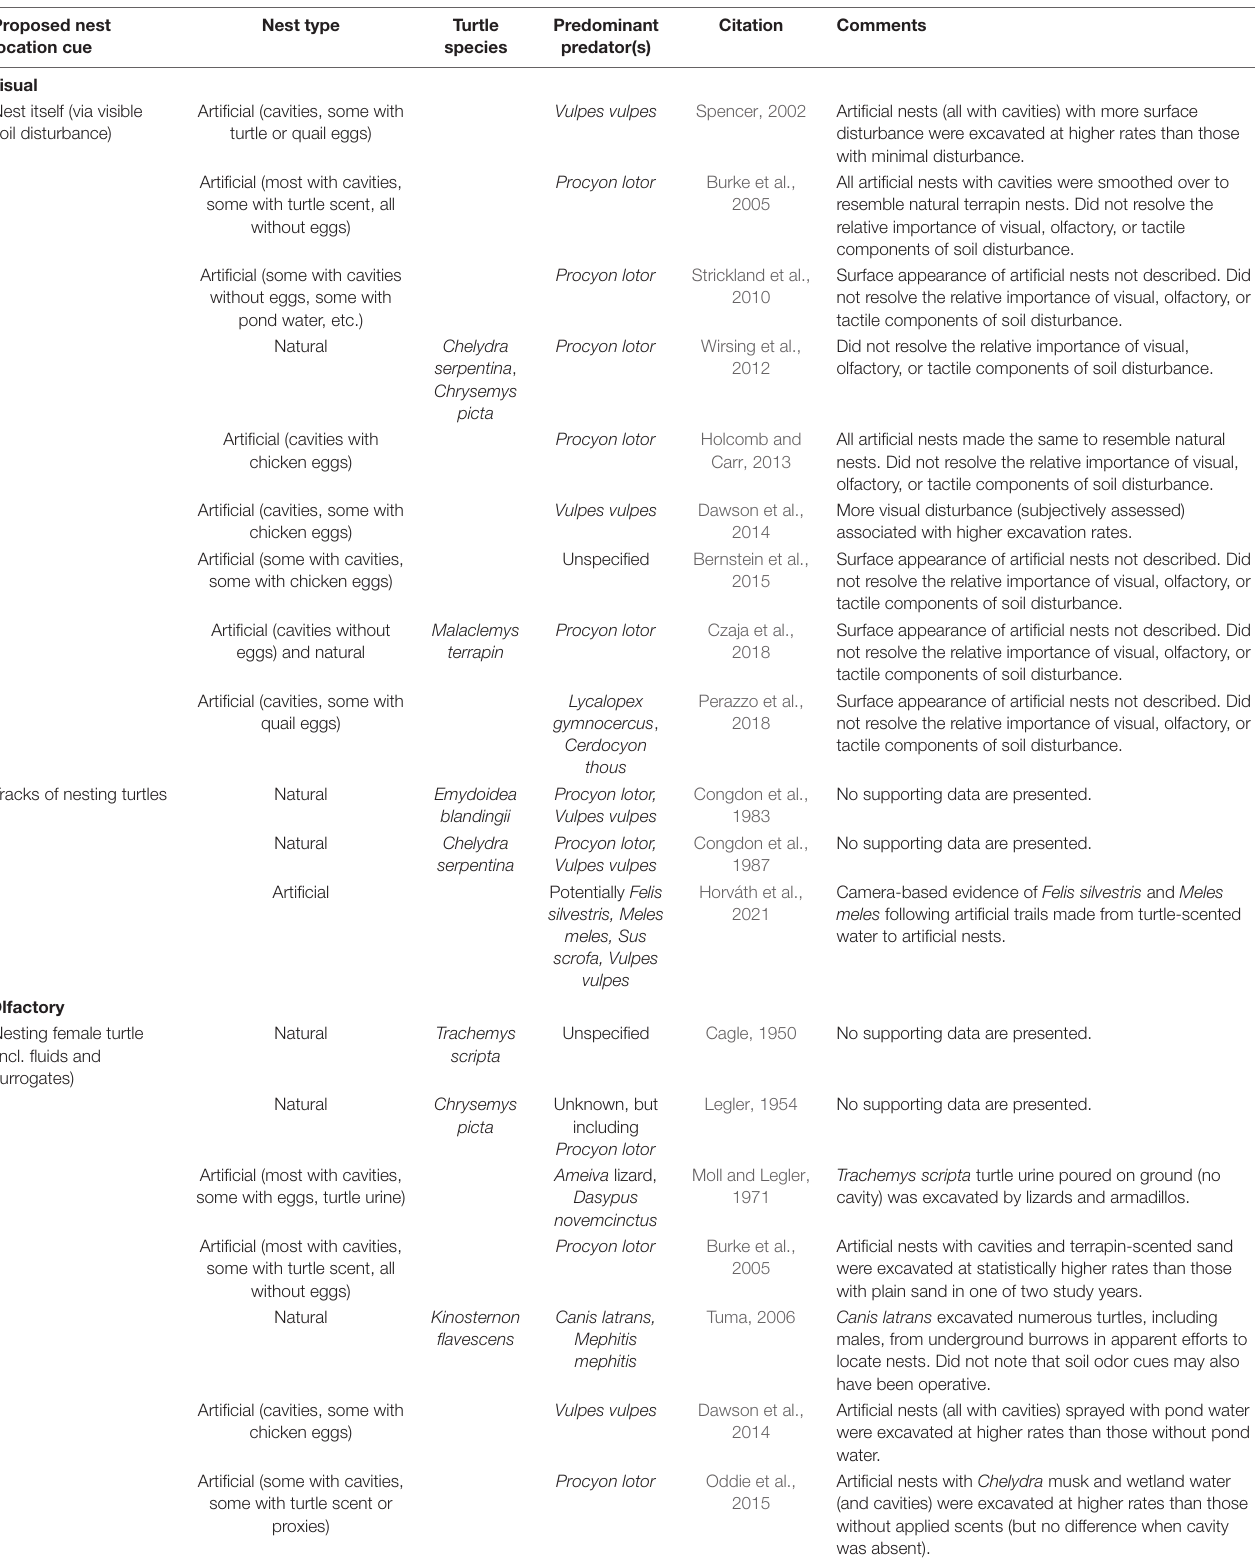
TABLE 2 | Papers proposing cues used by mammalian predators to locate freshwater turtle nests before the emergence